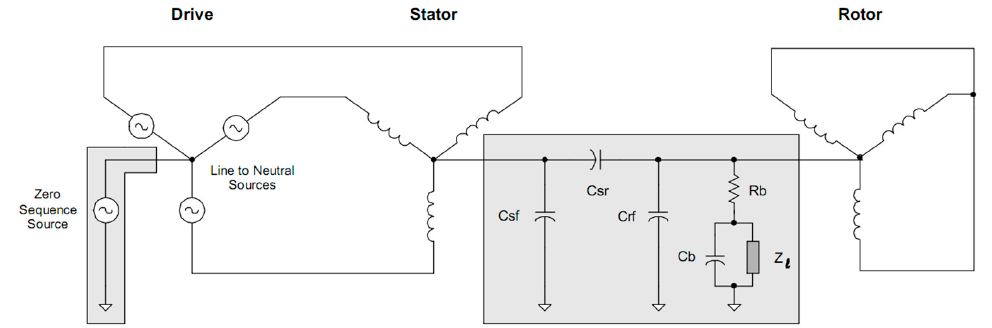
Figure 12. Inverter and motor shaft voltage model [24].